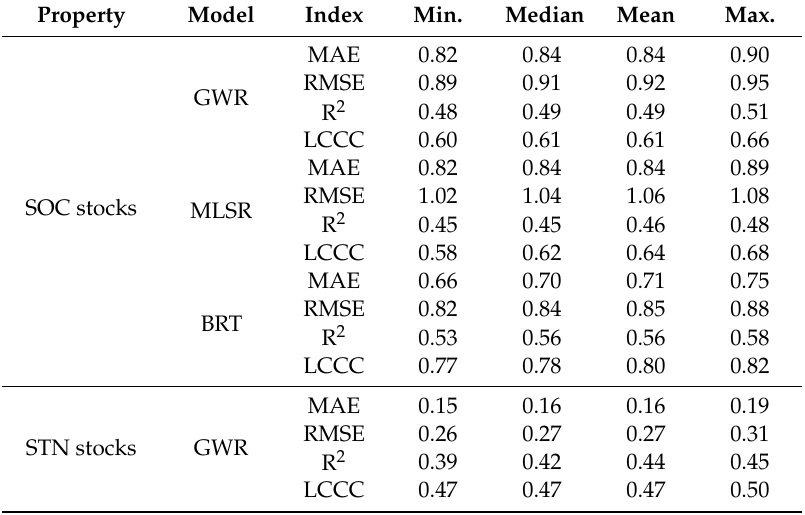
Table 4. Summary statistics of the predictive quality of geographically weighted regression (GWR), multiple stepwise linear regression (MSLR), and boosted regression trees (BRT) for topsoil (0–30 cm) SOC and STN stocks based on an independent dataset (n = 103) in